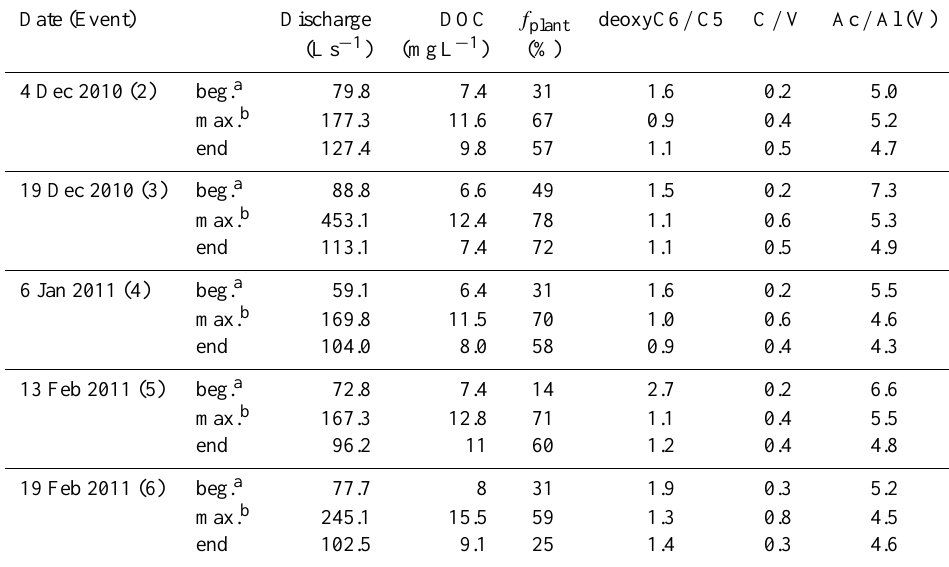
Table 1. Changes in discharge, DOC concentration and metrics of DOM composition during storm events. Values are given for the first, peak discharge, and final